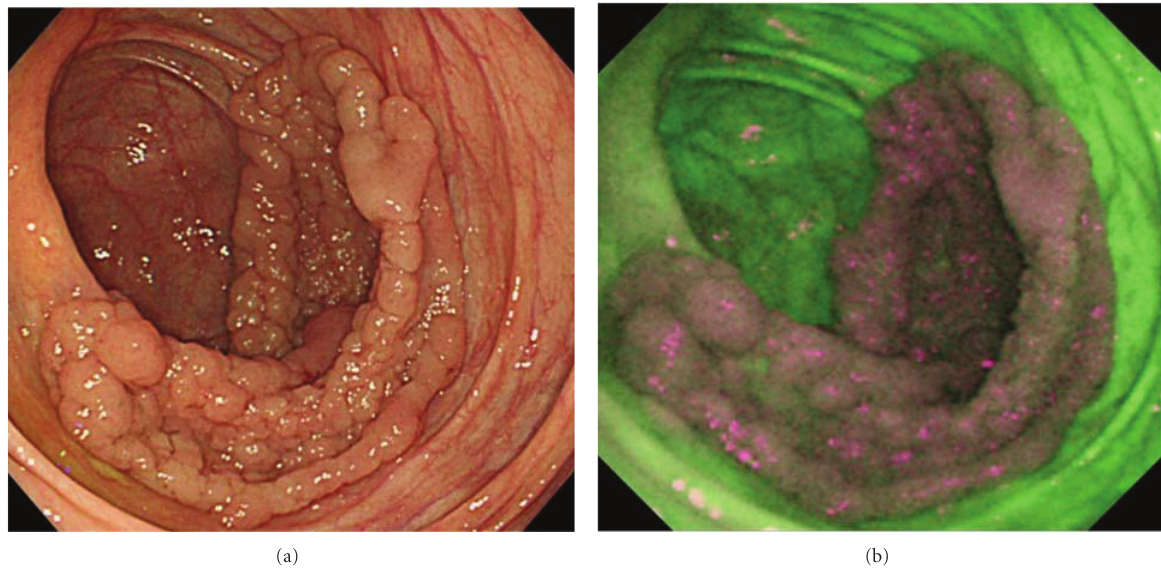
Figure 3: WLE image of 5-cm lateral spreading tumor (granular type) in cecum (a). With AFE, the lesion appears purple, which provides a strong color contrast with the surrounding normal mucosa shown in green